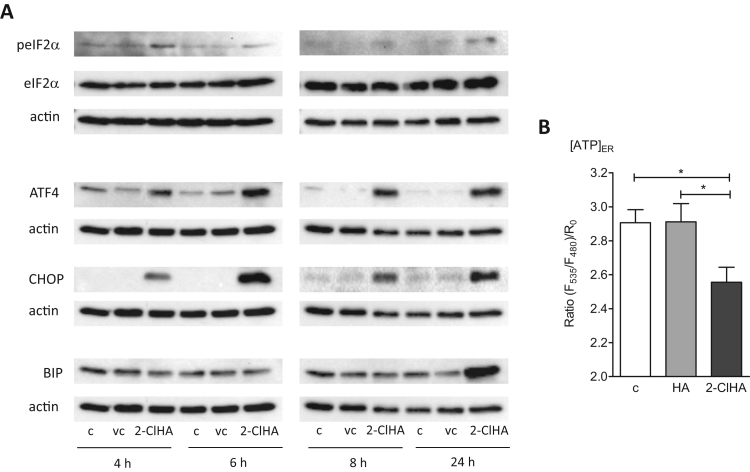
2-ClHA induces ER stress depletion of [ATP]ER in hCMEC/D3 cells. (A) Serum starved cells were incubated in the absence (c) or presence of DMSO (0.1%, vehicle control, vc) and 2-ClHA (10 μM) for the indicated time points. Total cell lysates were subjected to SDS-PAGE. Antibodies against p-eIF2α, eIF2α, ATF4, CHOP, and BiP were used as primary antibodies. β-Actin was used as loading control. For each protein one representative blot out of three independent experiments is shown. Densitometric and statistical evaluation of Western blot results is shown in Fig. S2. (B) Cells expressing ERAT4.01 were cultured in the absence (c), or presence of HA (25 µM; 30 min) or 2-ClHA (both 25 µM, 30 min) and the FRET ratio was acquired on a Zeiss AxioVert inverted microscope. Columns represent ratio signals of ERAT4.01 obtained for the respective treatment conditions. At least 28 cells were analyzed in two independent experiments.